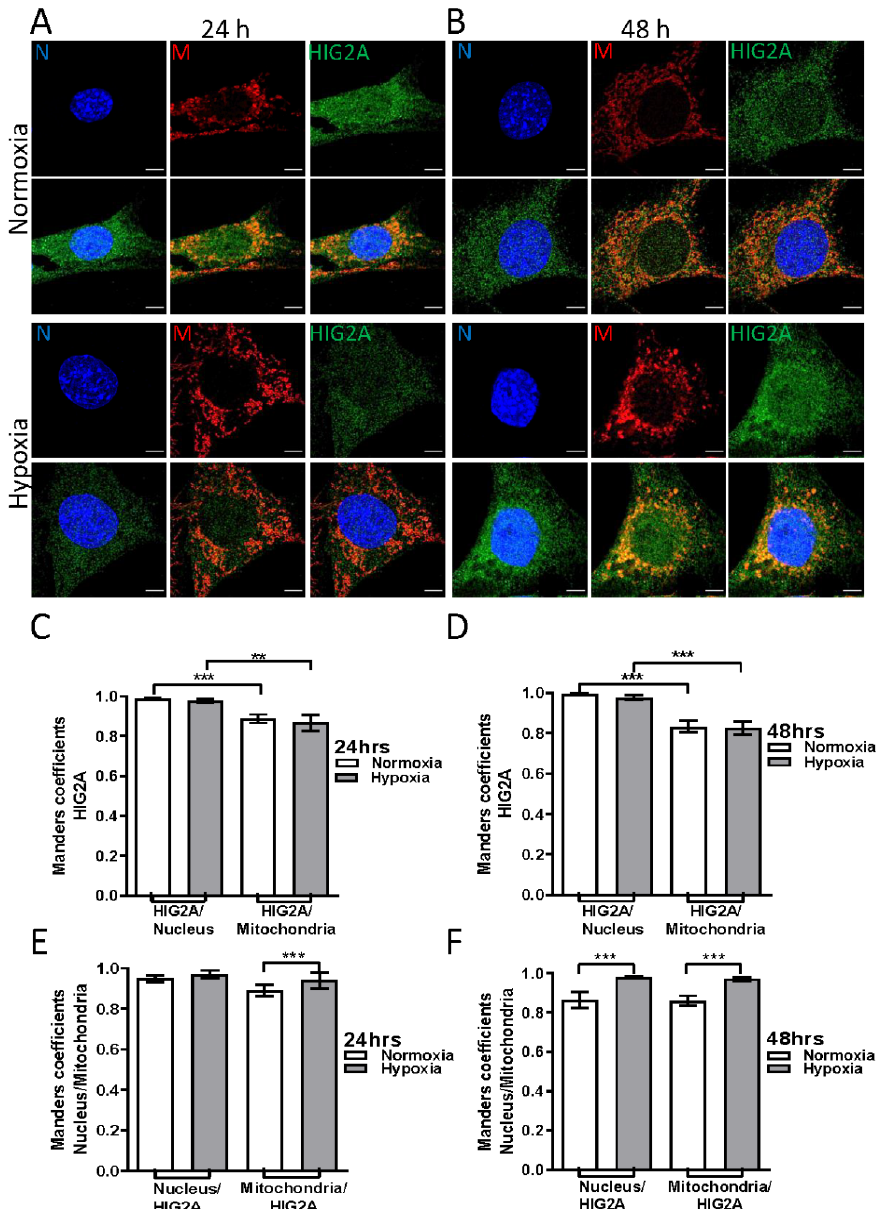
Figure 3. The effect of hypoxia on the subcellular localization of HIG2A in the mitochondria and the nucleus of C2C12 cells. The representative immunofluorescence images in C2C12 cells; anti-HIG2A primary antibody (Abcam ab135399), DyLight ® 488 secondary antibody (HIG2A green). MitoTracker TM Red CM-H2XRos mitochondrial fluorescent marker (M red). Hoescht 33342 (blue signal—DNA). Z-axis series were obtained using confocal microscopy (Leica TCS SP8). The separation between each of the slices (Z step size) was 0.130 microns. The C2C12 cells were subjected to hypoxic stress (2% O 2 ) for 24-h ( A , C , E ) and 48-h ( B , D , F ). The quantification of colocalization was performed using Manders’ coefficient. The fluorescence signal corresponding to HIG2A was quantified over the fluorescence signal of the nucleus (HIG2A/nucleus [M2]) ( C , D ) and over the signal of the mitochondria (HIG2A/mitochondria [M1]) ( C , D ). Each bar graph represents the mean ± SE, n = 4 biological replicates, 20 cells were analyzed per condition; they were analyzed by a one-tailed t -test ( p < 0.05), followed by a Mann-Whitney test. Statistical differences were found with a significance of p -value (*** p ≤ 0.0001 ( C ), ** p ≤ 0.0073 ( C ), *** p ≤ 0.0001 ( D ), *** p ≤ 0.0002 ( D ), *** p ≤ 0.0002 ( E ), *** p ≤ 0.0004 ( F ), *** p ≤ 0.0002 ( F )). ** Very significant (0.001 to 0.01). *** Extremely significant (0.0001 to 0.001). White bars indicate a 5 µ m